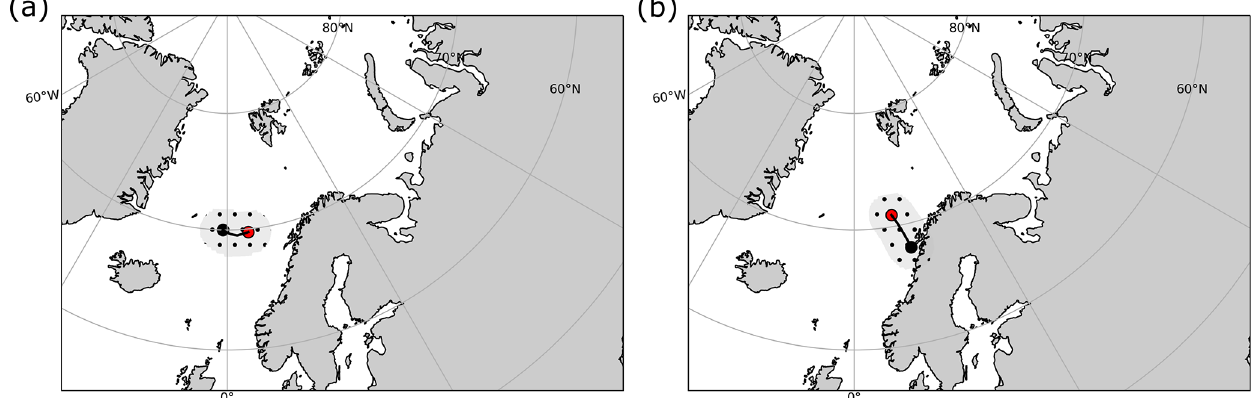
Figure B1. Examples of randomly generated pseudo-events to test performance of diagnostic indices. (a) One of the pseudo-events generated in winter 2006. (b) One of the pseudo-events generated in winter 2007. Pseudo-events are defined at randomly selected times and locations when no PL was observed to test whether diagnostic indices are useful for distinguishing occurrence and non-occurrence of